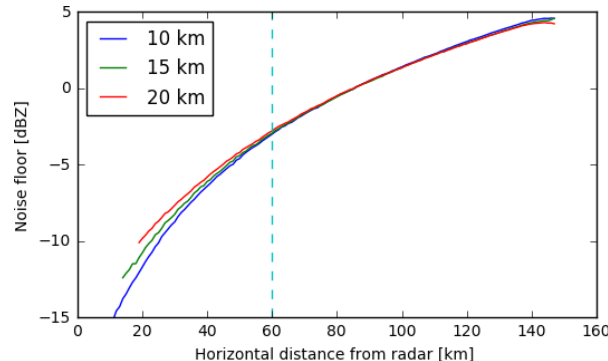
Figure 1. Minimum detectable signal of CPOL as a function of hor- izontal distance from CPOL for three vertical